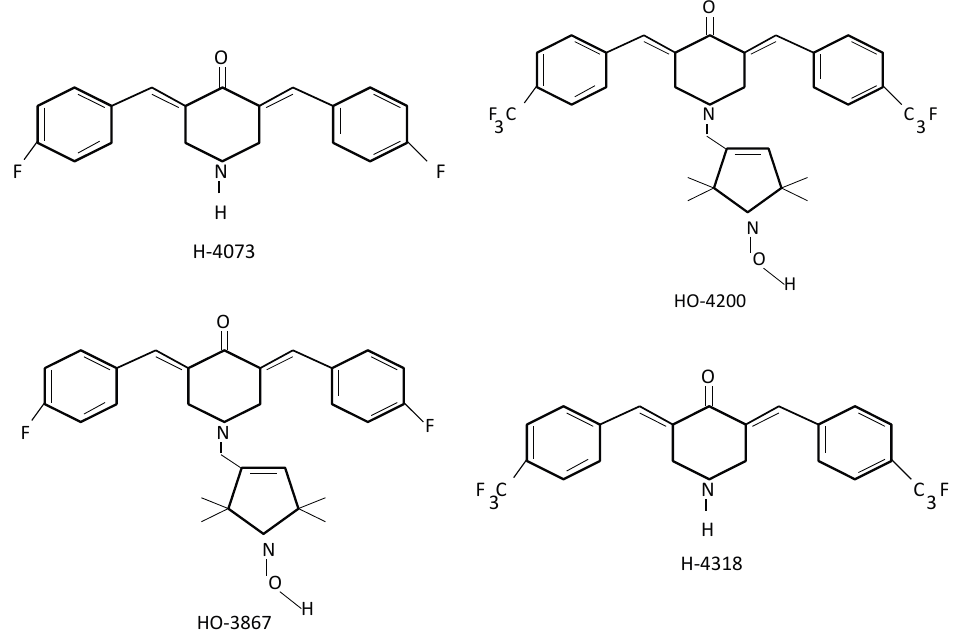
Figure 2. Structures of diarylidenyl piperidones (DAPs) [63].